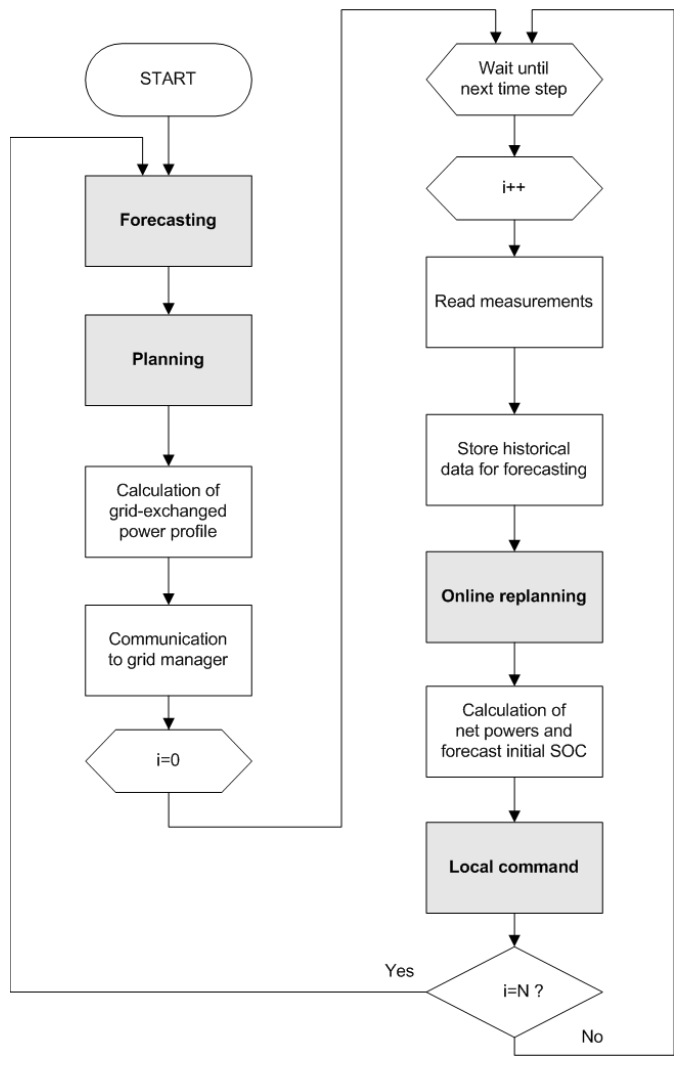
Figure 1. Flowchart of the proposed